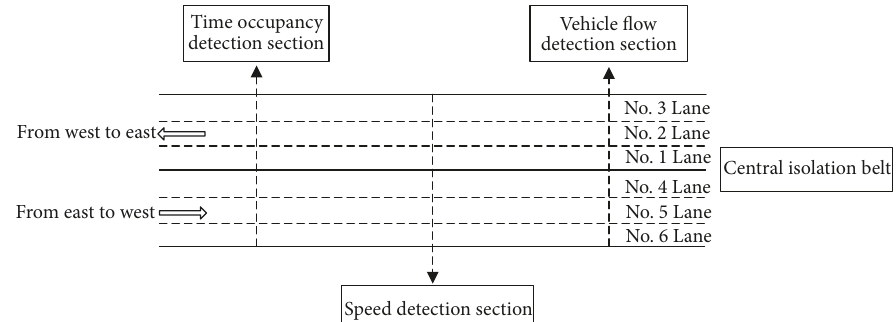
Figure 3: Road observation diagram.